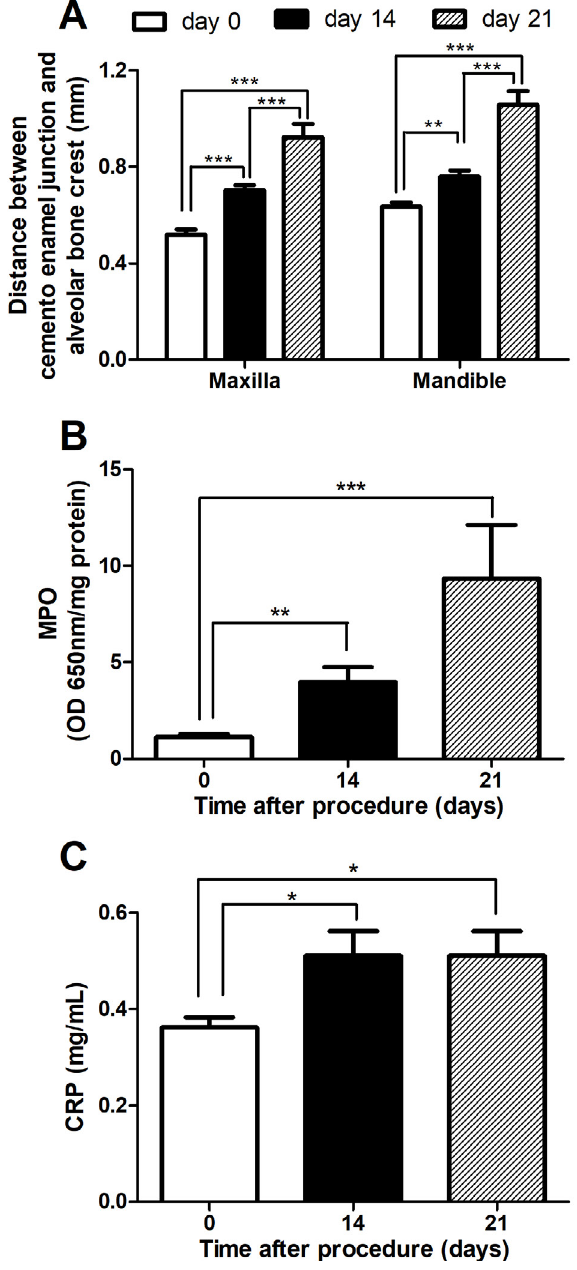
Figure 2- Local and systemic effects induced by periodontitis. Bone loss of the maxilla and mandible was measured on day 0, 14 days, or 21 days after the ligature procedure (A). Bone loss was quantified as the distance between the cement enamel junction and the alveolar crest (in mm). Myeloperoxidase (MPO) activity was also measured in the gingival tissue around the ligated molars (B). Blood was collected and assayed for C-reactive protein (CRP) (C). Statistical analysis was performed using one-way analysis of variance followed by Bonferroni post hoc test. *p<0.05, **p<0.01, and